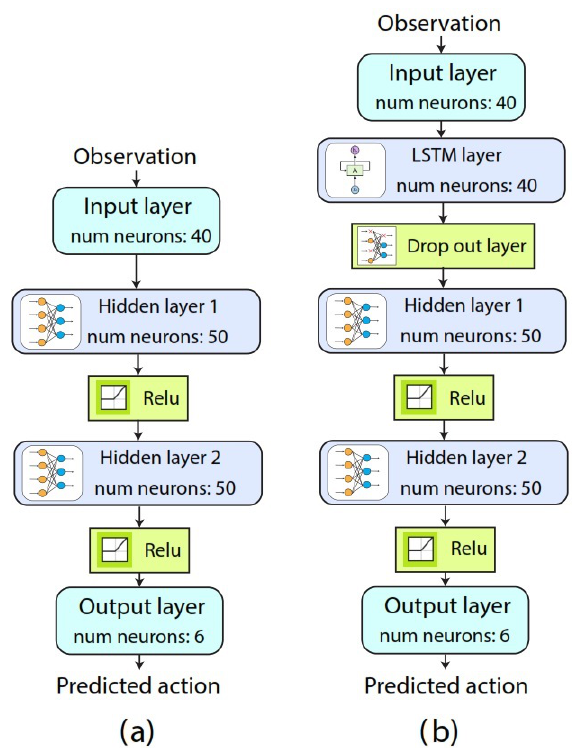
Figure 4. Representations proposed for the agents. ( a ) A neural network representation. ( b ) A Neural network representation with an LSTM recurrent